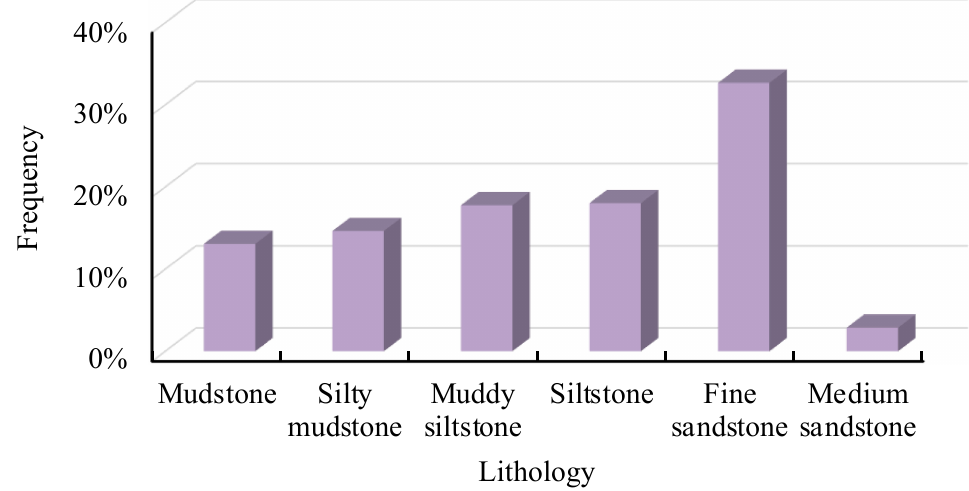
Figure 8. Fracture development of different types of lithology.